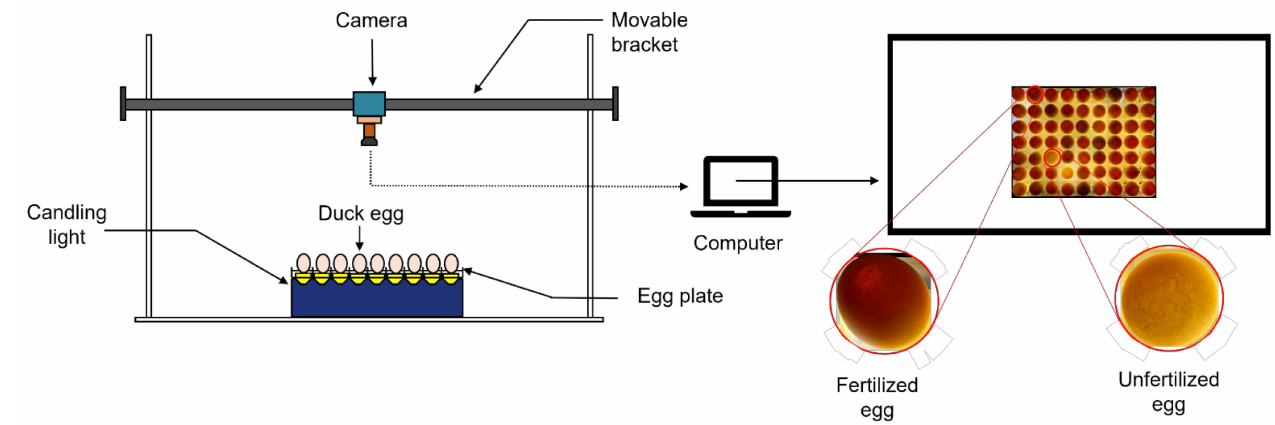
Figure 1. Scheme of the image acquisition